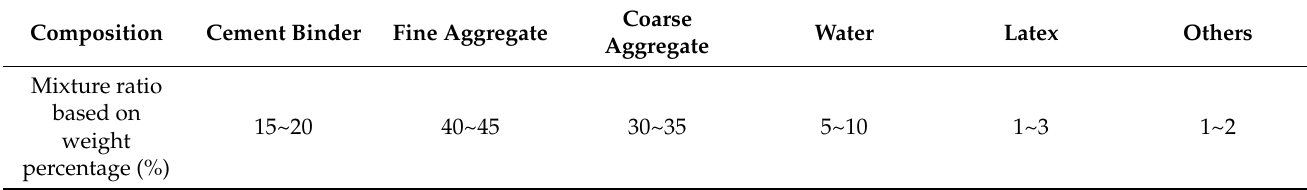
Table 4. LMC pavement material